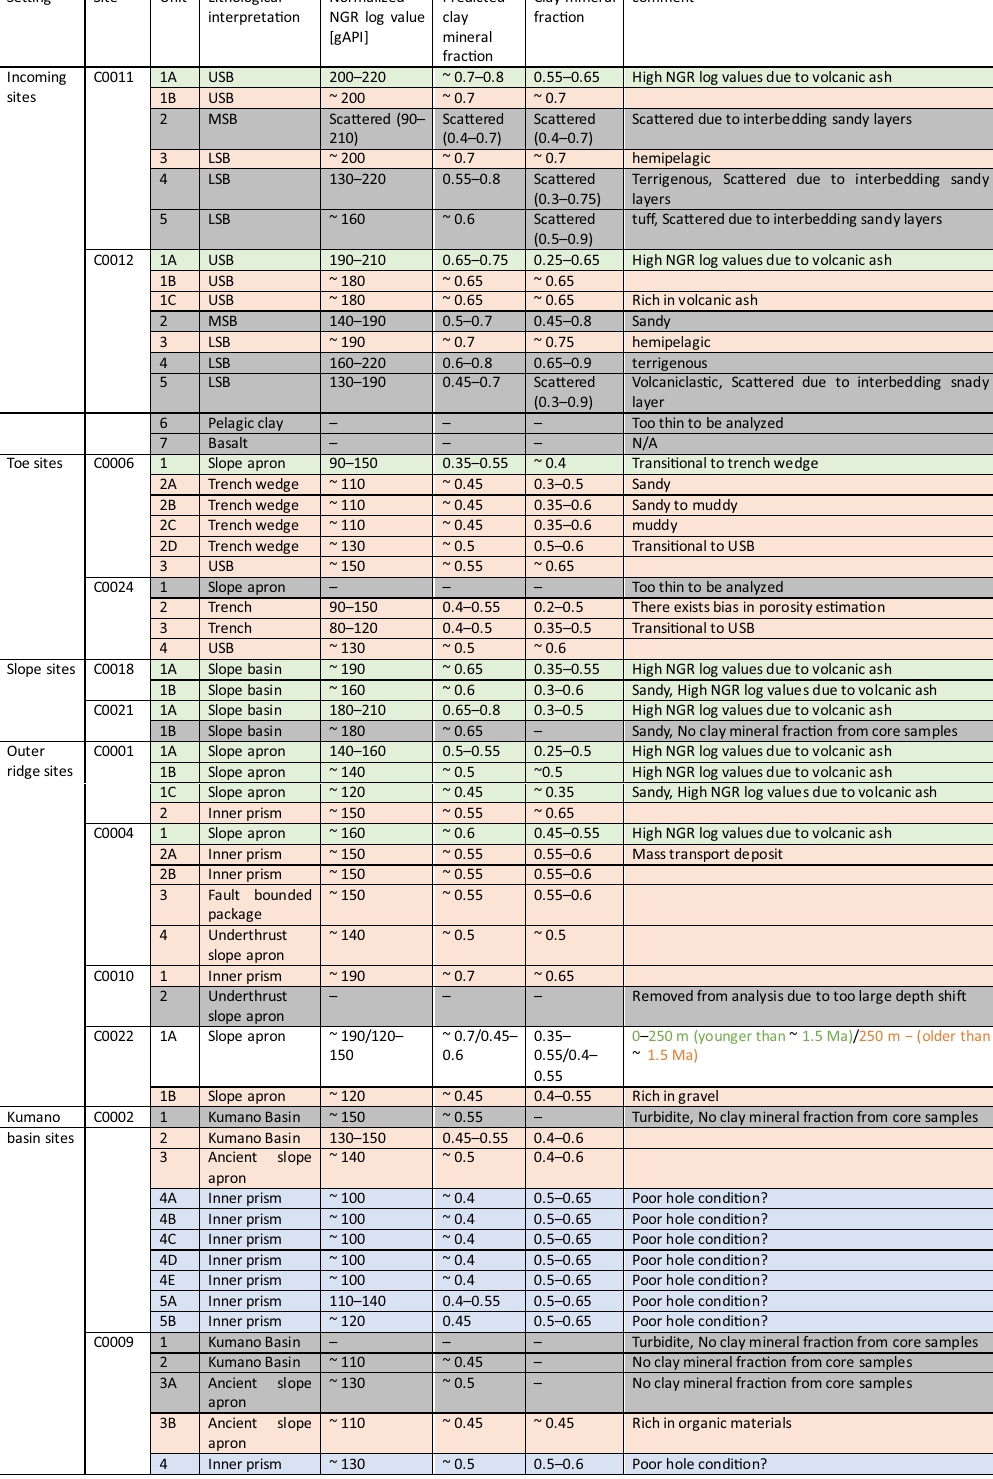
Table 1 A summary table for all sites studied in this study Se(cid:31)ng Site Unit Lithological